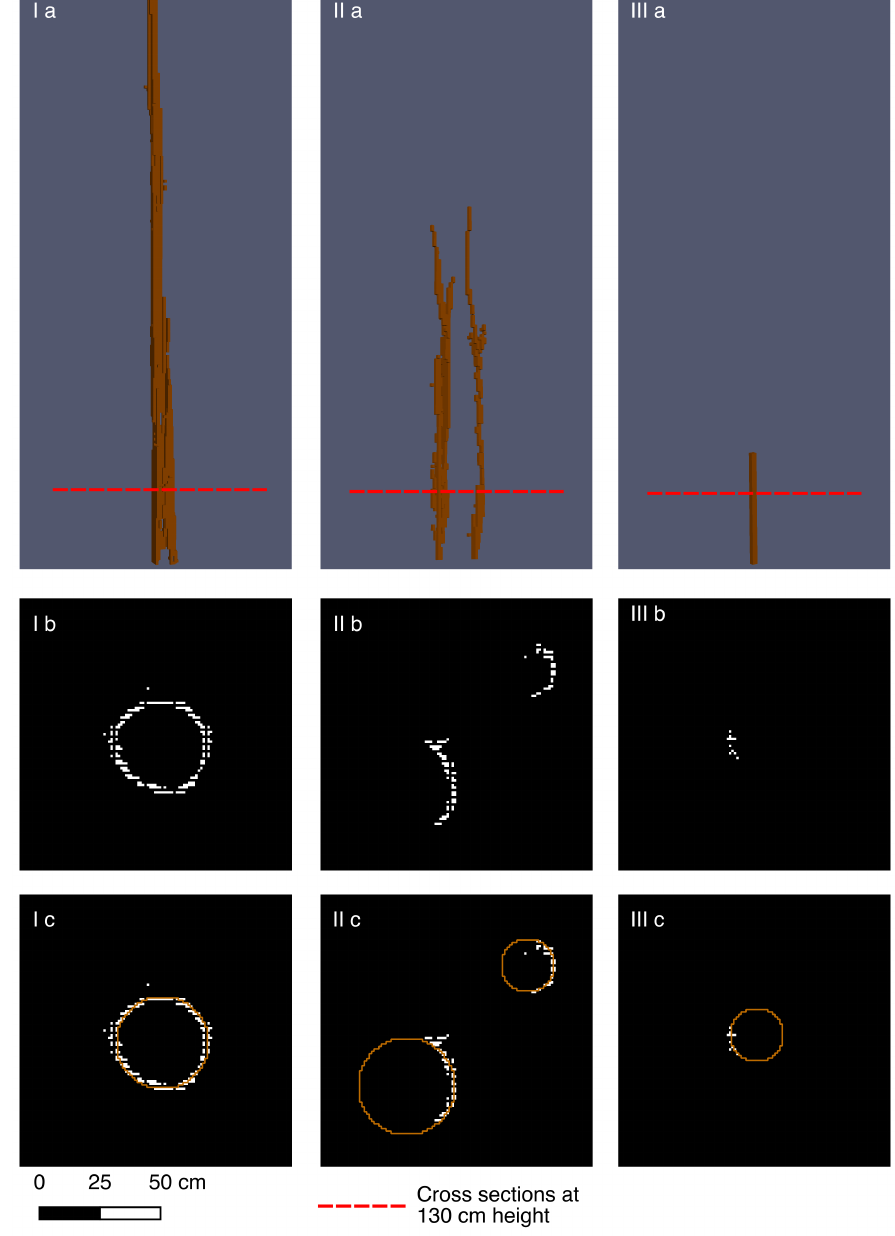
Figure 5. Three examples (I)–(III) of circles fitted to tree stem cross sections covering different fractions of the original stem circumference. For all examples images ( a ) show the isolated 3D tree stem objects in the coarser resolution voxel grids; images ( b ) show the resampled higher resolution cross sections at 130 cm height and images ( c ) depict the circles fitted to the cross